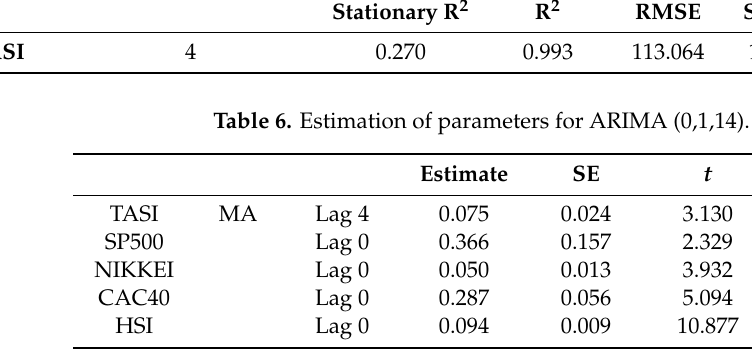
Table 6. Estimation of parameters for ARIMA (0,1,14).